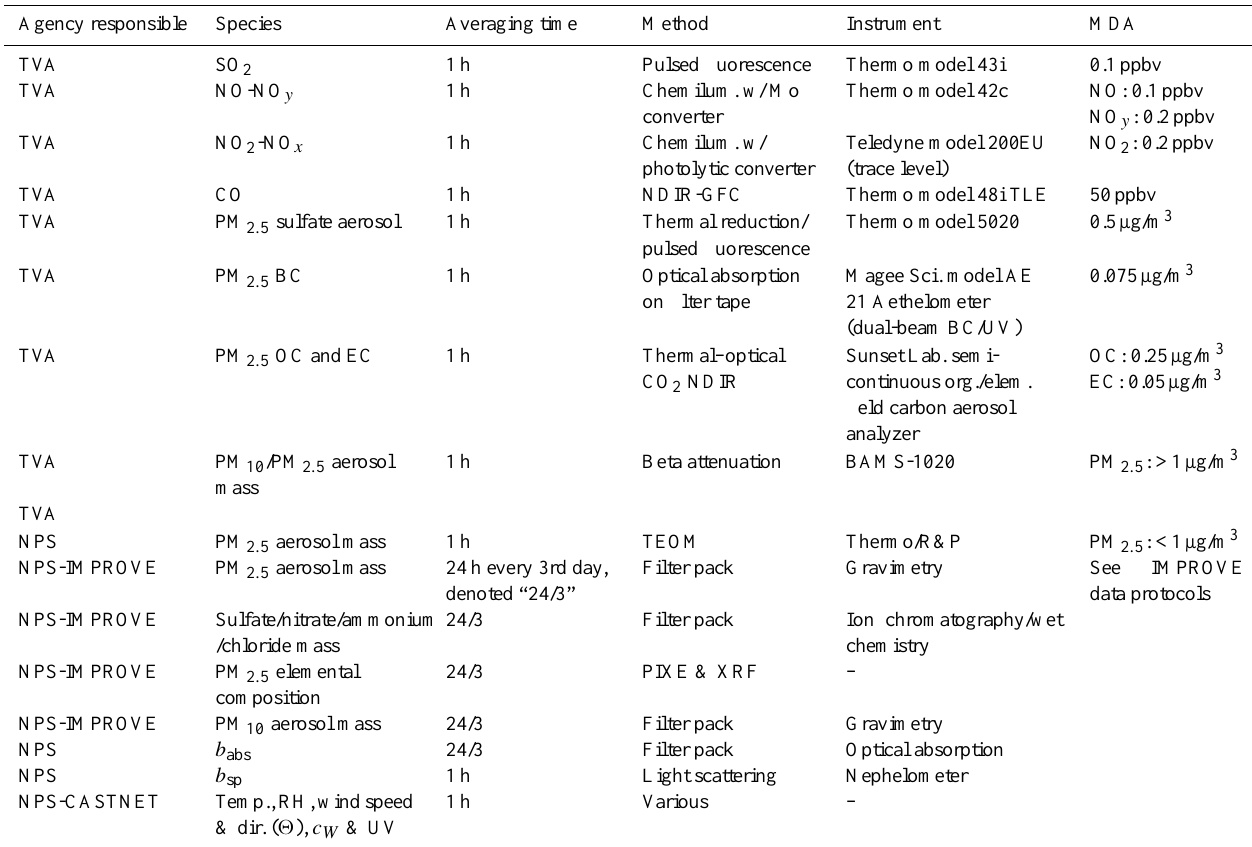
Table 1. Routine instrumentation deployed at Look Rock. Agency